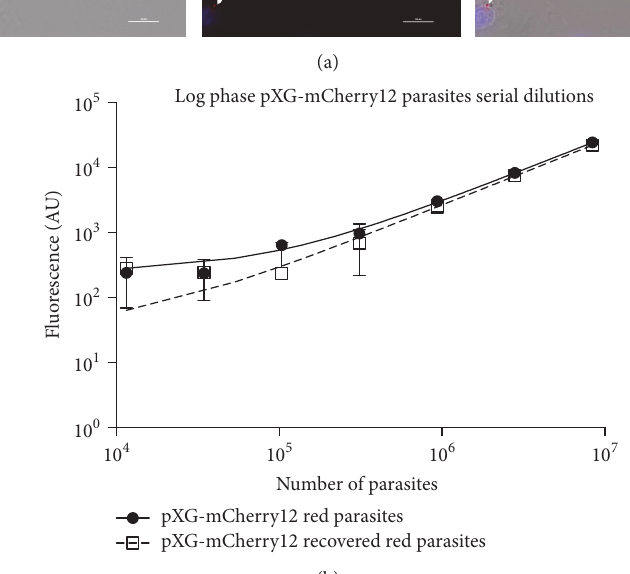
Figure 4: pXG-mCherry12 transfected parasites preserve their fluorescence during in vitro and after in vivo infections. (a) Murine peritoneal macrophages infected with red fluorescent parasites. Solid white arrows indicate fluorescent amastigotes. Microscopy images were acquired with a Nikon Eclipse E800 confocal microscope. (b) Fluorescence emitted from pXG-mCherry12 promastigotes recovered after in vivo infection. 96-well plates were read with a FLUOstar Optima plate reader using 570-nm excitation and 620-nm absorbance